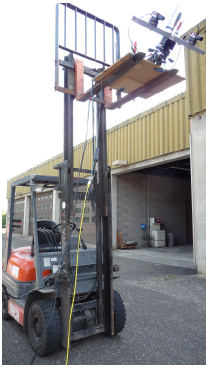
Figure 9. The SR4500 is fixed on a forklift for outdoor internal calibration